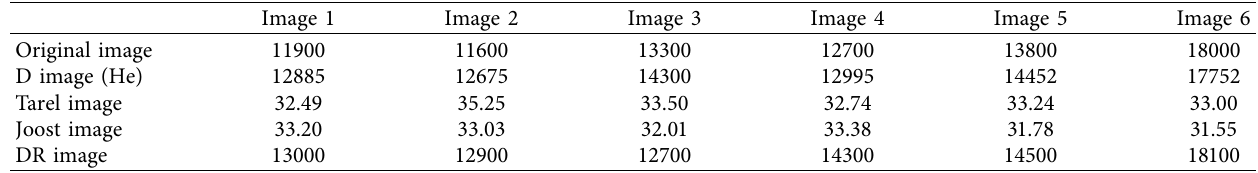
Table 4: Standard deviation for the six sets of effect charts.